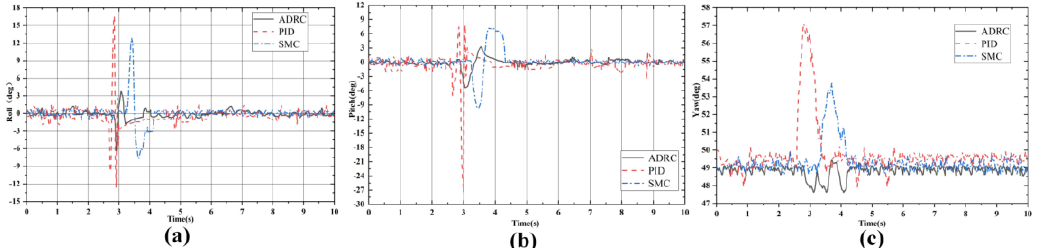
Figure 10. Experimental results of attitude angle control of PID, SMC, and ADRC out-of-water motion: ( a ) roll angle, ( b ) pitch angle, ( c ) yaw angle.